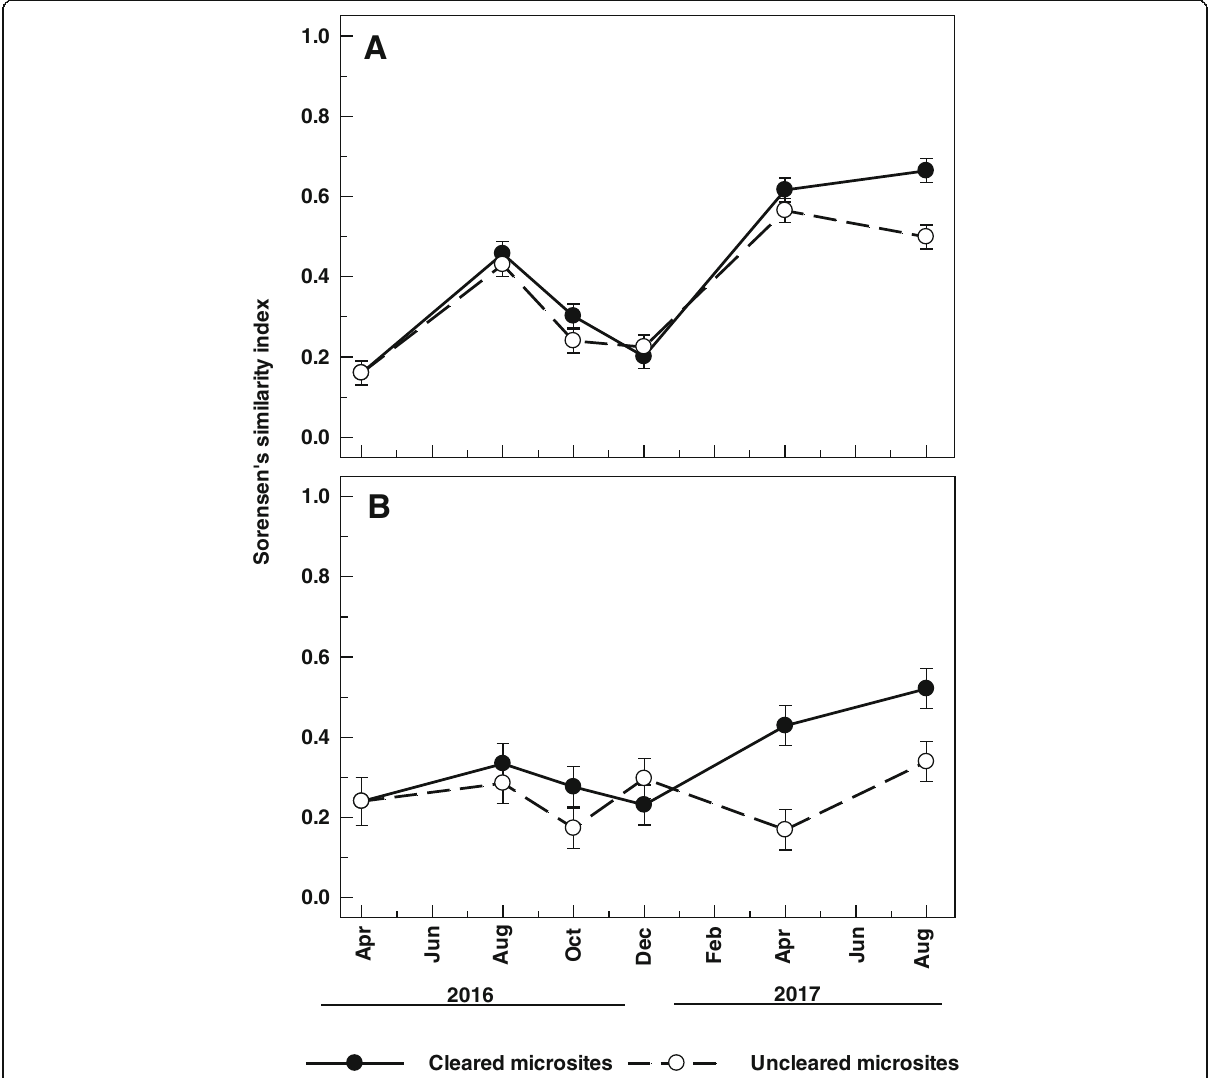
Fig. 5 Similarity index between soil seed bank and aboveground vegetation in cleared and uncleared microsites at Maseding ( a ) and Kgomokgomo ( b ) from April 2016 to August 2017. The presented data are back-transformed means and error bars represent ± standard error of